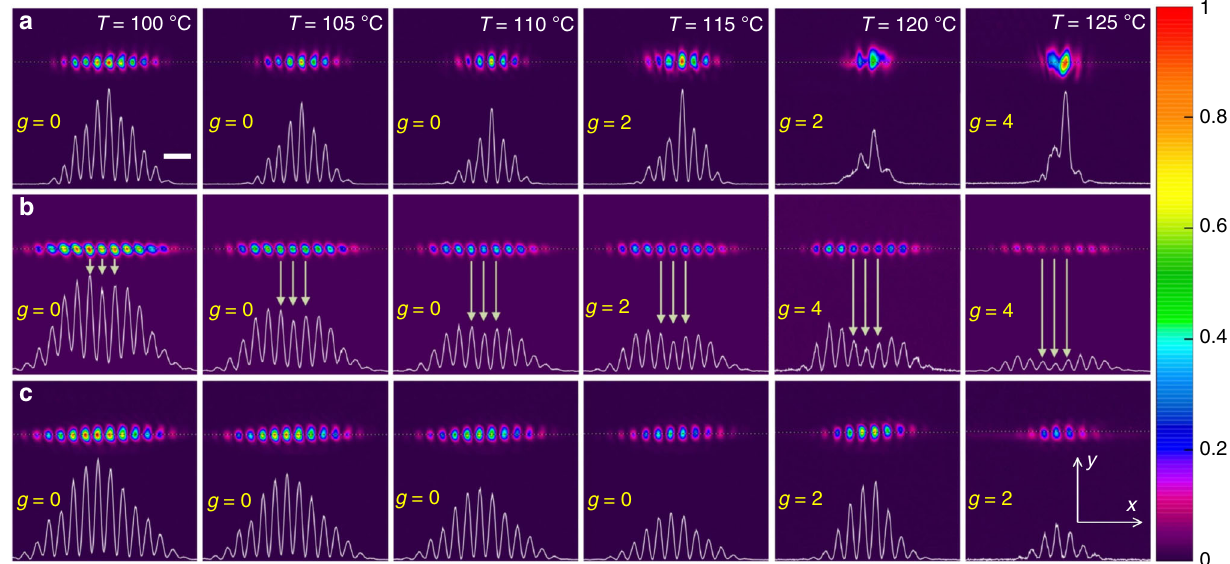
Fig. 4 Focusing, defocusing, and diffraction-free propagation of the nonlinear edge states. a Self-focusing of the edge state at n 2 > 0 ( Δ 1 = 140 MHz) with increase of temperature. Scale bar: 200 μ m. b Self-defocusing of the edge state at n 2 < 0 ( Δ 1 = 125 MHz) with increase of the temperature. c Formation of diffraction-free edge states under the action of focusing nonlinearity n 2 > 0 ( Δ 1 = 135 MHz) weaker than in panel a , when the pattern keeps the same functional form for different temperatures. The probe power is 400 μ W . b , c share the same scale bar as ( a